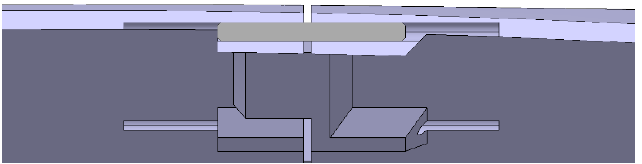
Figure 17. Sectional view of a dowel pin inside two segments with a convex surface.